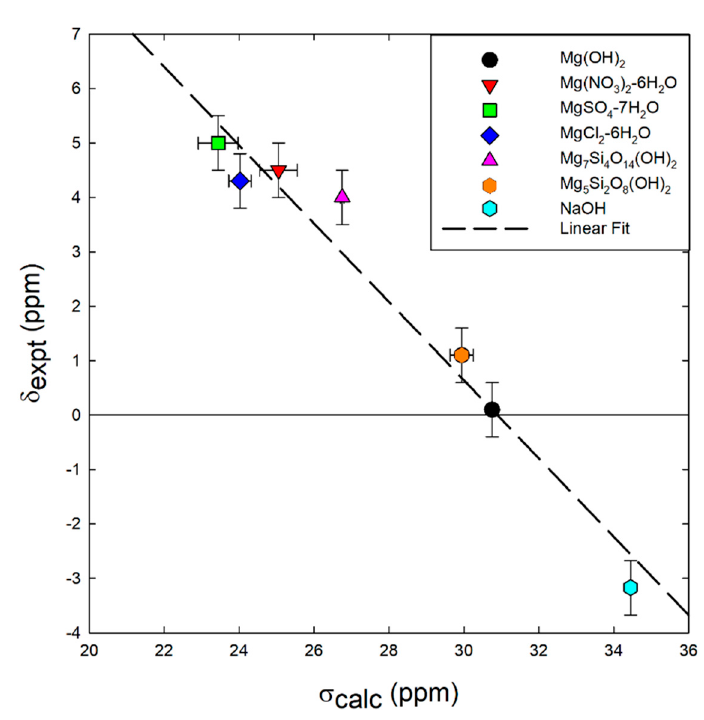
Figure 4. Correlation (R 2 = 0.9268) between the average computational 1 H-NMR shielding and experimental chemical shift for select MgO crystalline structures.